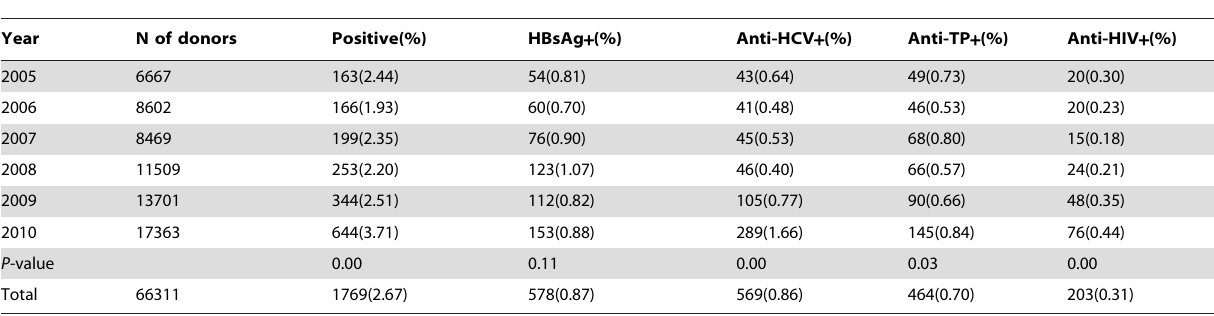
Table 3. Positivity rate of transfusion-transmissible infections, 2005–2010.